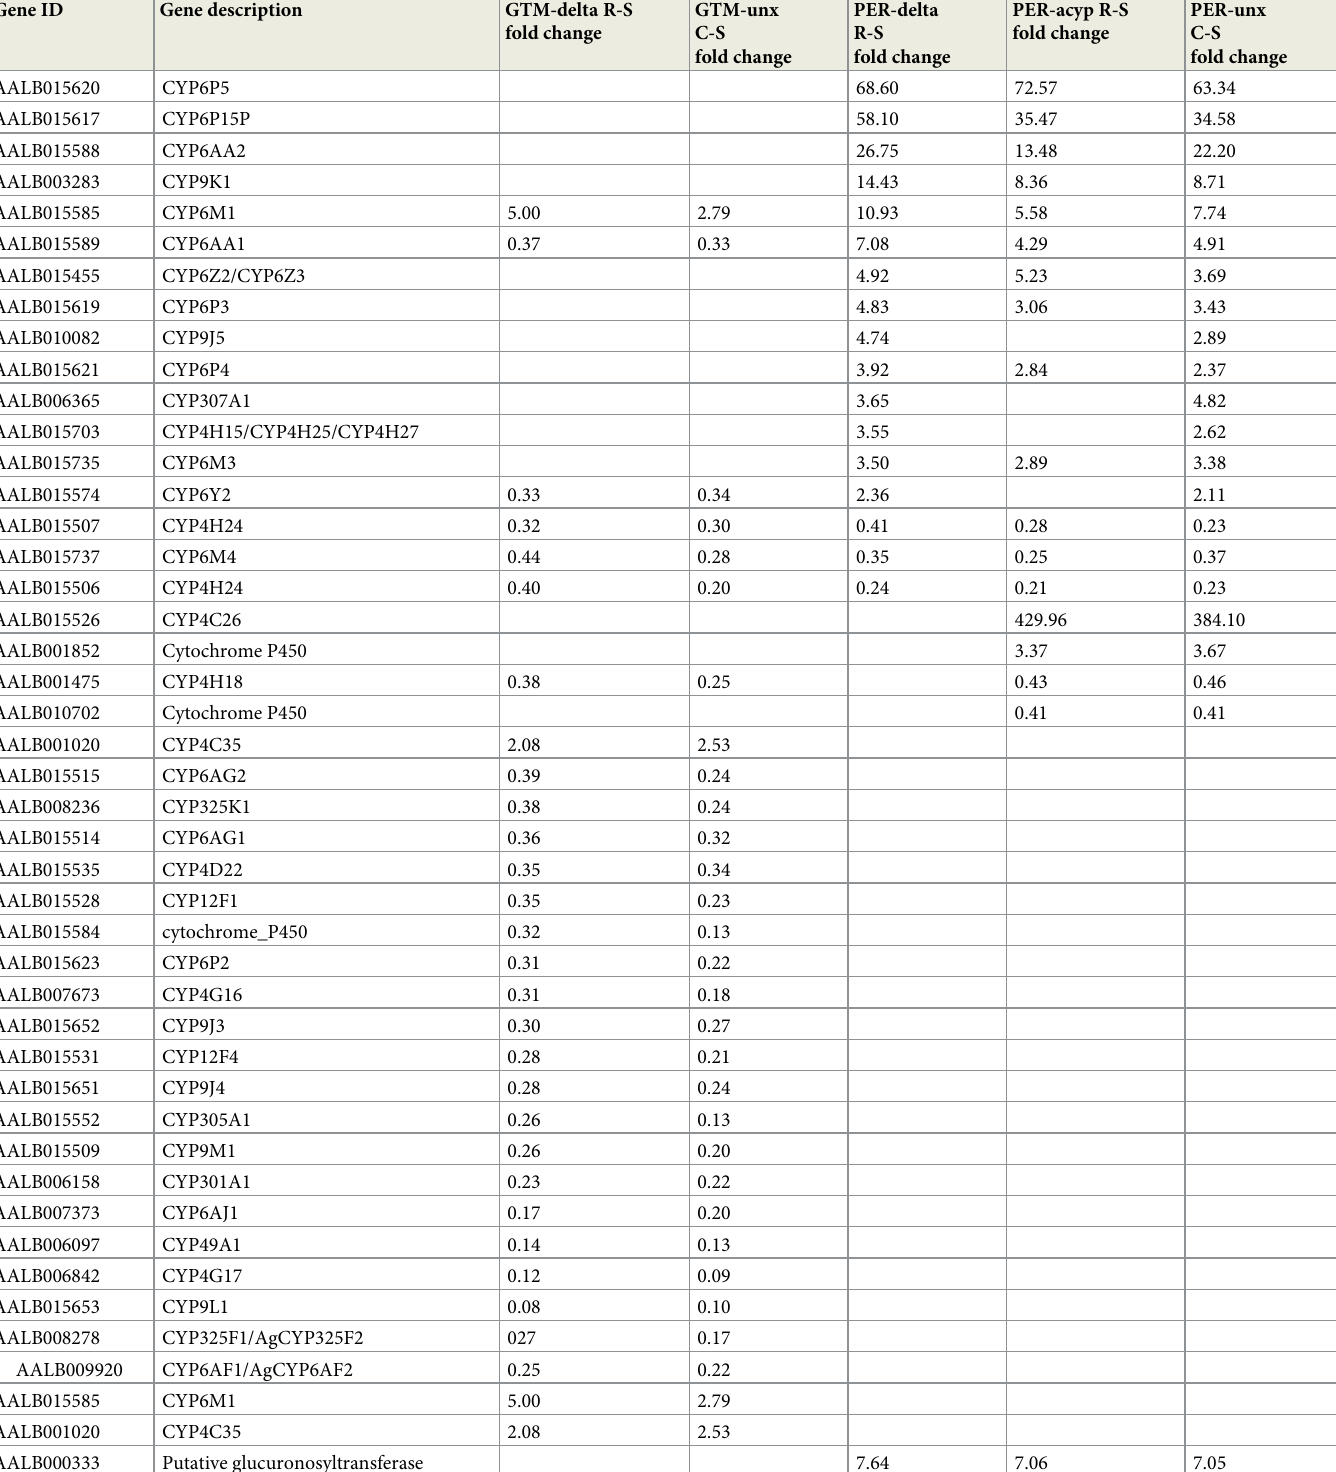
Table 2. Differentially expressed detoxification genes common in the comparisons of resistant vs. susceptible (R-S) and control vs. susceptible (C-S) groups, with a corrected p value < 0.05. Gene description is based on orthology to An . gambiae . Gene